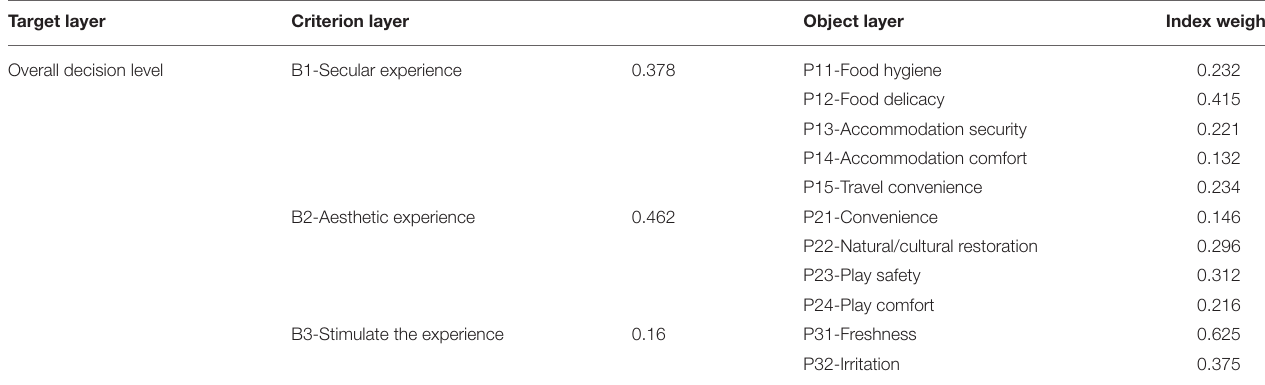
TABLE 4 | Building an index system for the Macau smart travel service platform based on big